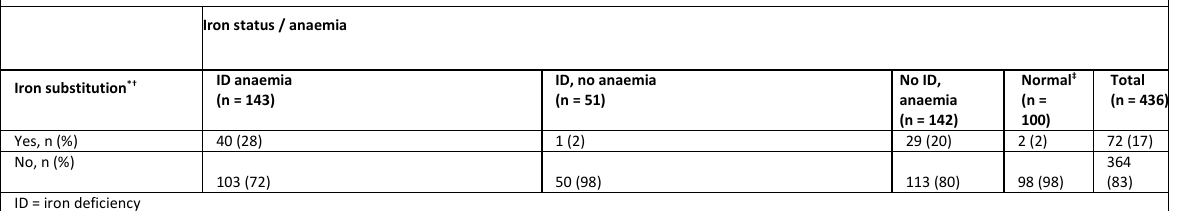
Table 3: Iron substitution stratified by iron status and presence of anaemia on hospital admission (number of patients =